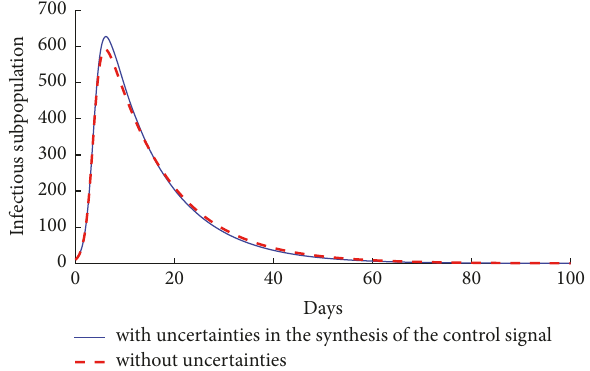
with uncertainties in the synthesis of the control signal without uncertainties Figure 22: Infectious subpopulations with (i) the vaccination strategy designed if there are uncertainties in the measures of the subpopulations and (ii) the basic vaccination strategy without